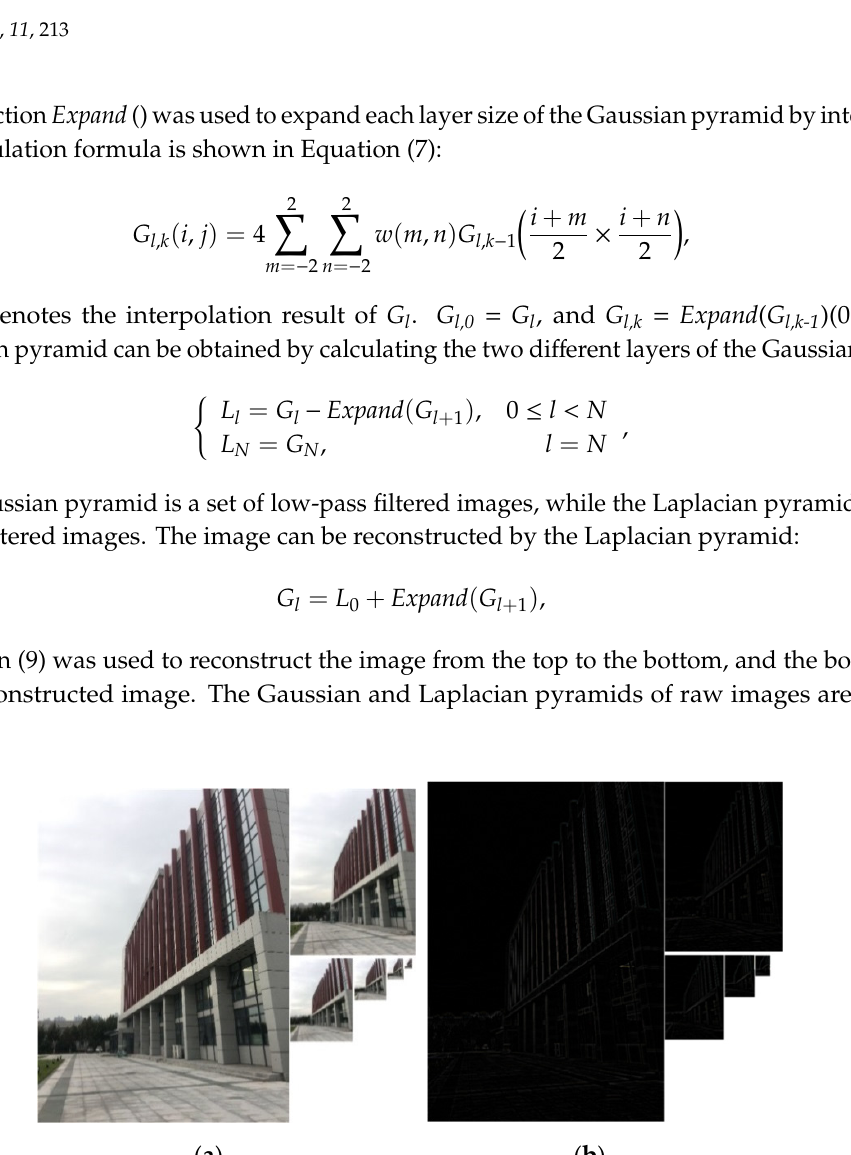
( b ) Figure 7. High-dynamic-range (HDR) fusion results. ( a ) Fusion result; ( b ) clipped result.